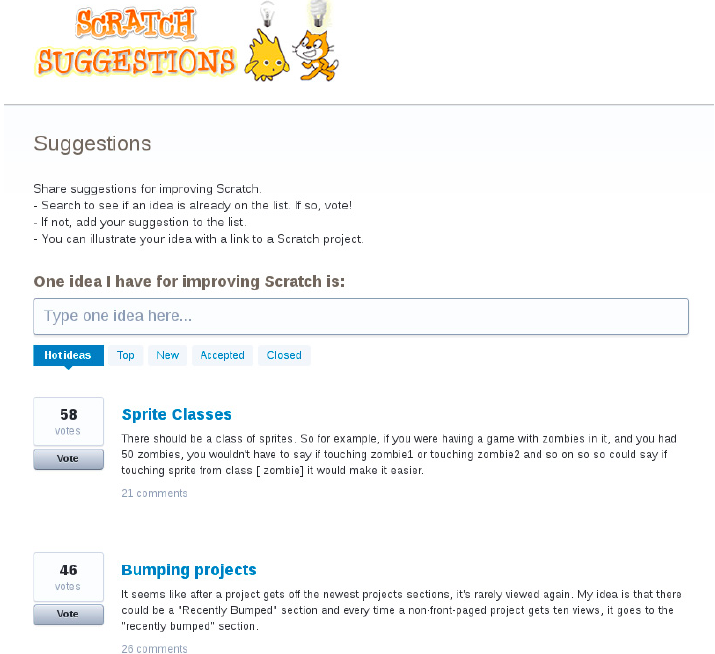
Figure 7. The homepage of the Scratch Suggestions website.